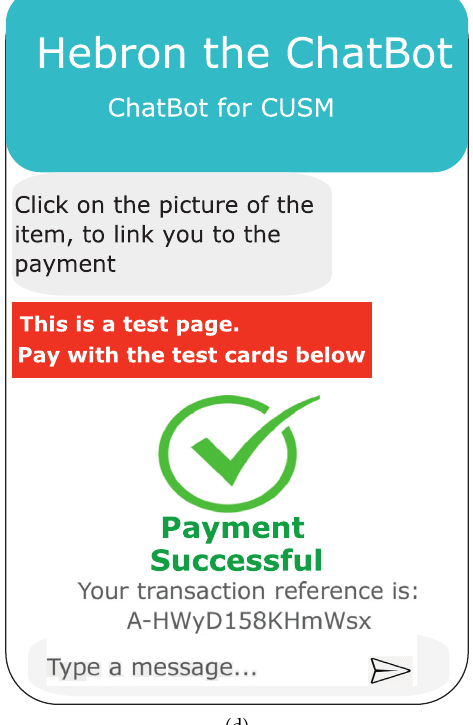
Figure 5: (a) Chatbot interface. (b) User requesting items from a chatbot. (c) User paying for an item via chatbot. (d) Successful